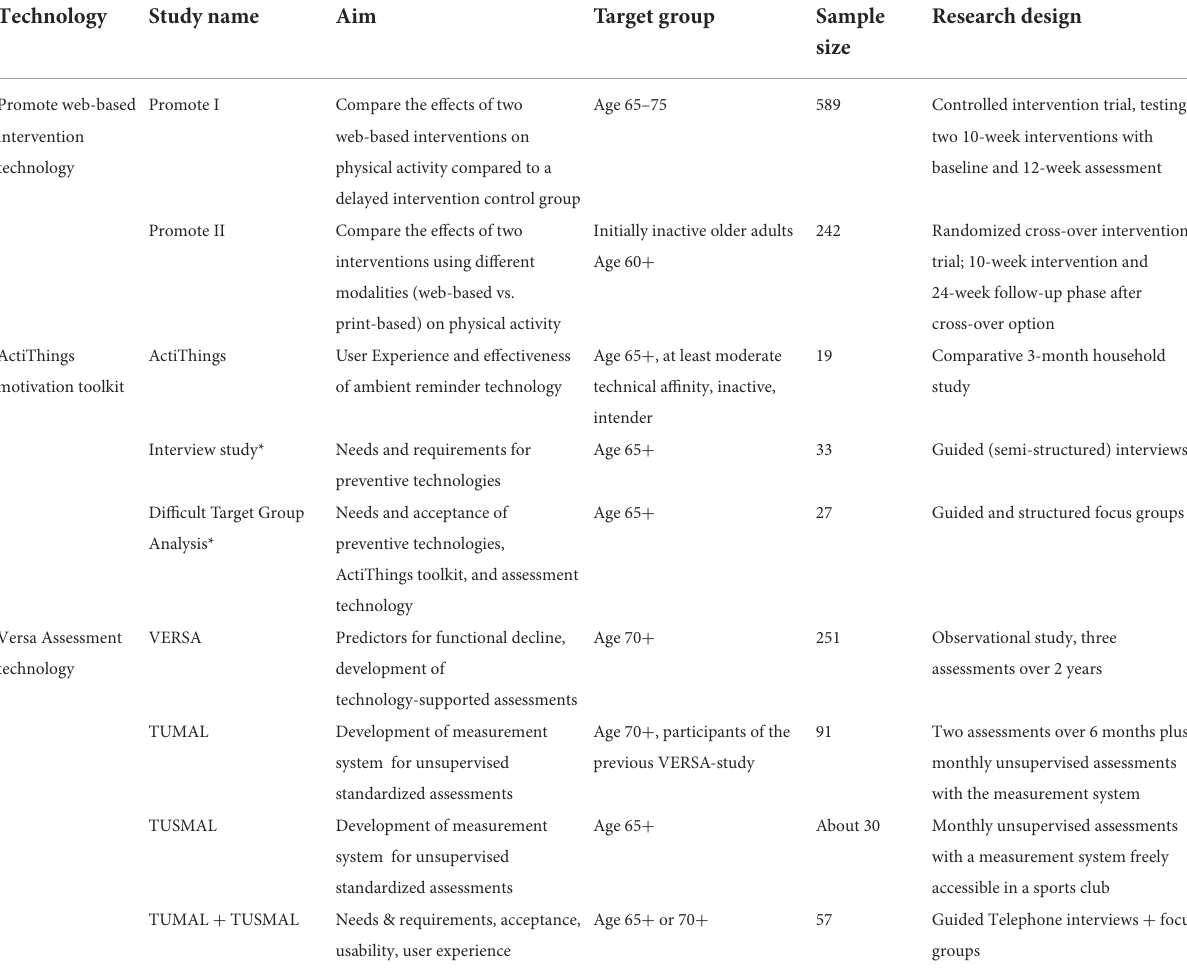
TABLE 1 Overview AEQUIPA technology and sub-studies covered within the article.